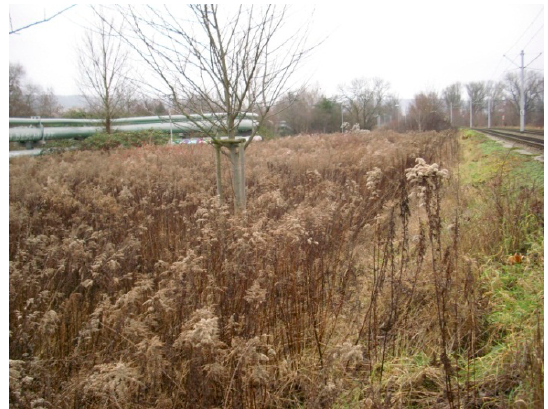
Figure 1. The invasive Giant goldenrod stand at Jena-Burgau in November 2009.